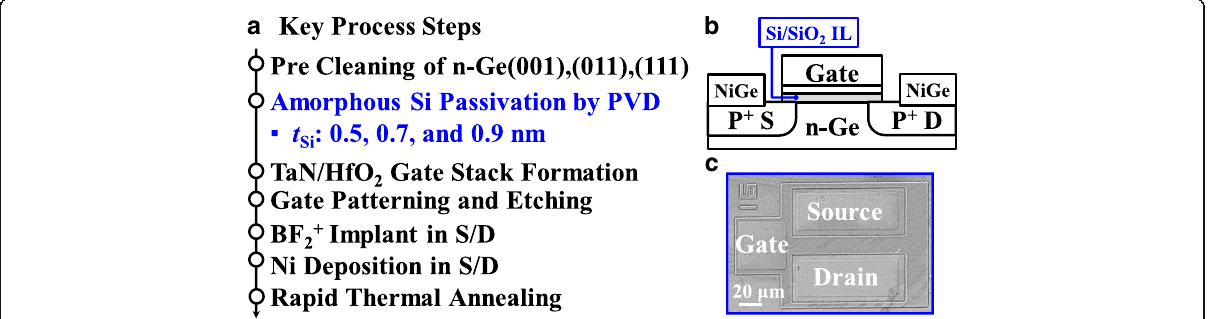
Fig. 1 a Process sequence showing the key steps employed to fabricate the Ge pMOSFETs with different t Si . b Cross-sectional schematic of a Ge pMOSFET with SiO 2 IL. c Top-view microscope image of a fabricated Ge